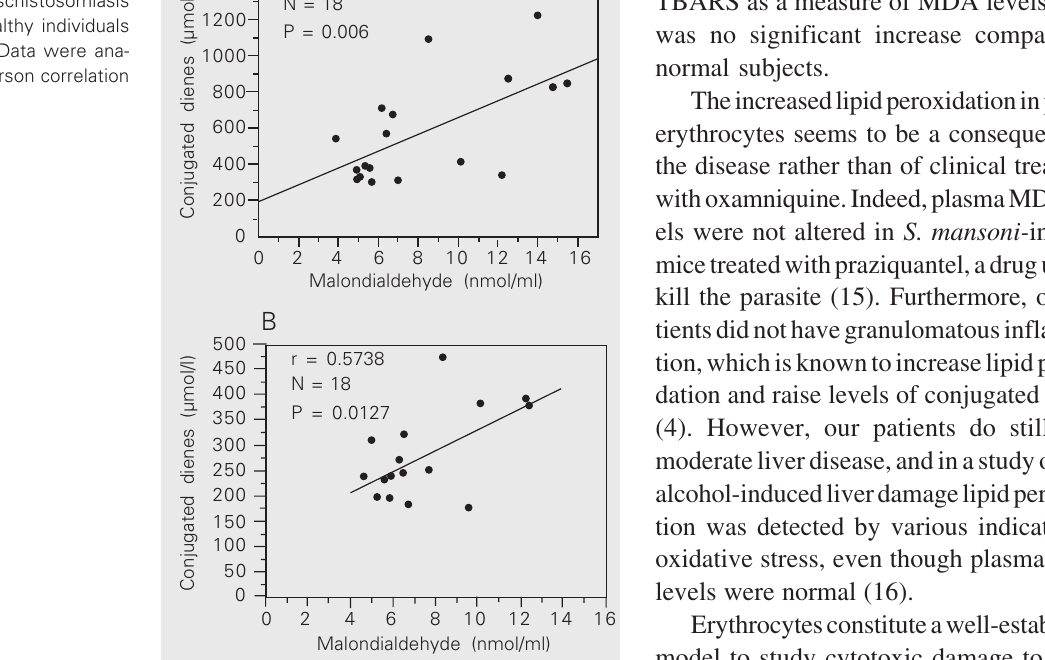
2. Correlation between plasma malondialdehyde and erythrocyte-conjugated dienes. A , Patients with schistosomiasis mansoni. B , Healthy individuals (control group). Data were ana- lyzed by the Pearson correlation